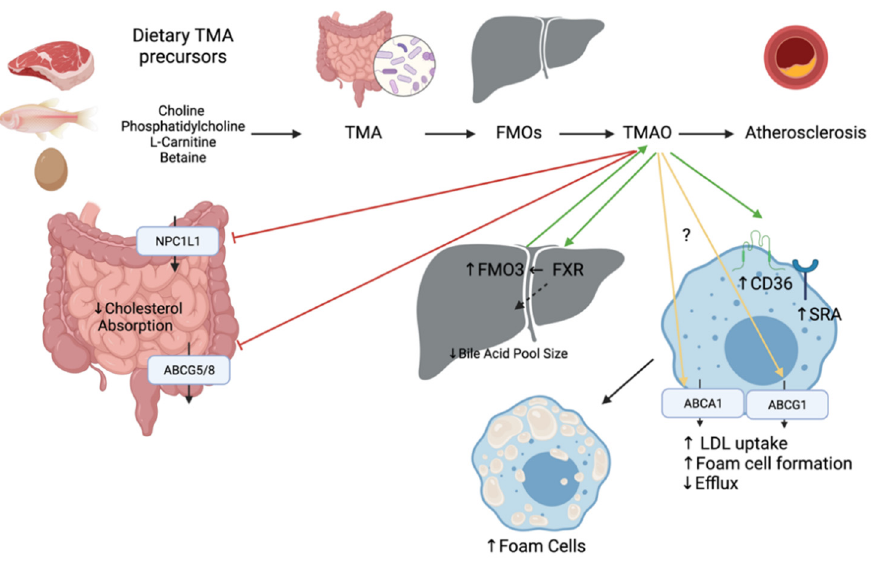
Figure 5. Mechanisms linking the pro-atherosclerotic activity of gut microbial metabolite TMAO and cholesterol transport and synthesis in the intestine, liver, and macrophage. The intestinal microbiota metabolizes choline, phosphatidylcholine, L-carnitine, and betaine to trimethylamine (TMA), which is oxidized into TMAO by hepatic flavin monooxygenases (FMO). Green arrows indicate an increase of expression or activation whereas red arrows indicate a reduction of the expression. Yellow arrows indicate that the results in the literature are controversial.